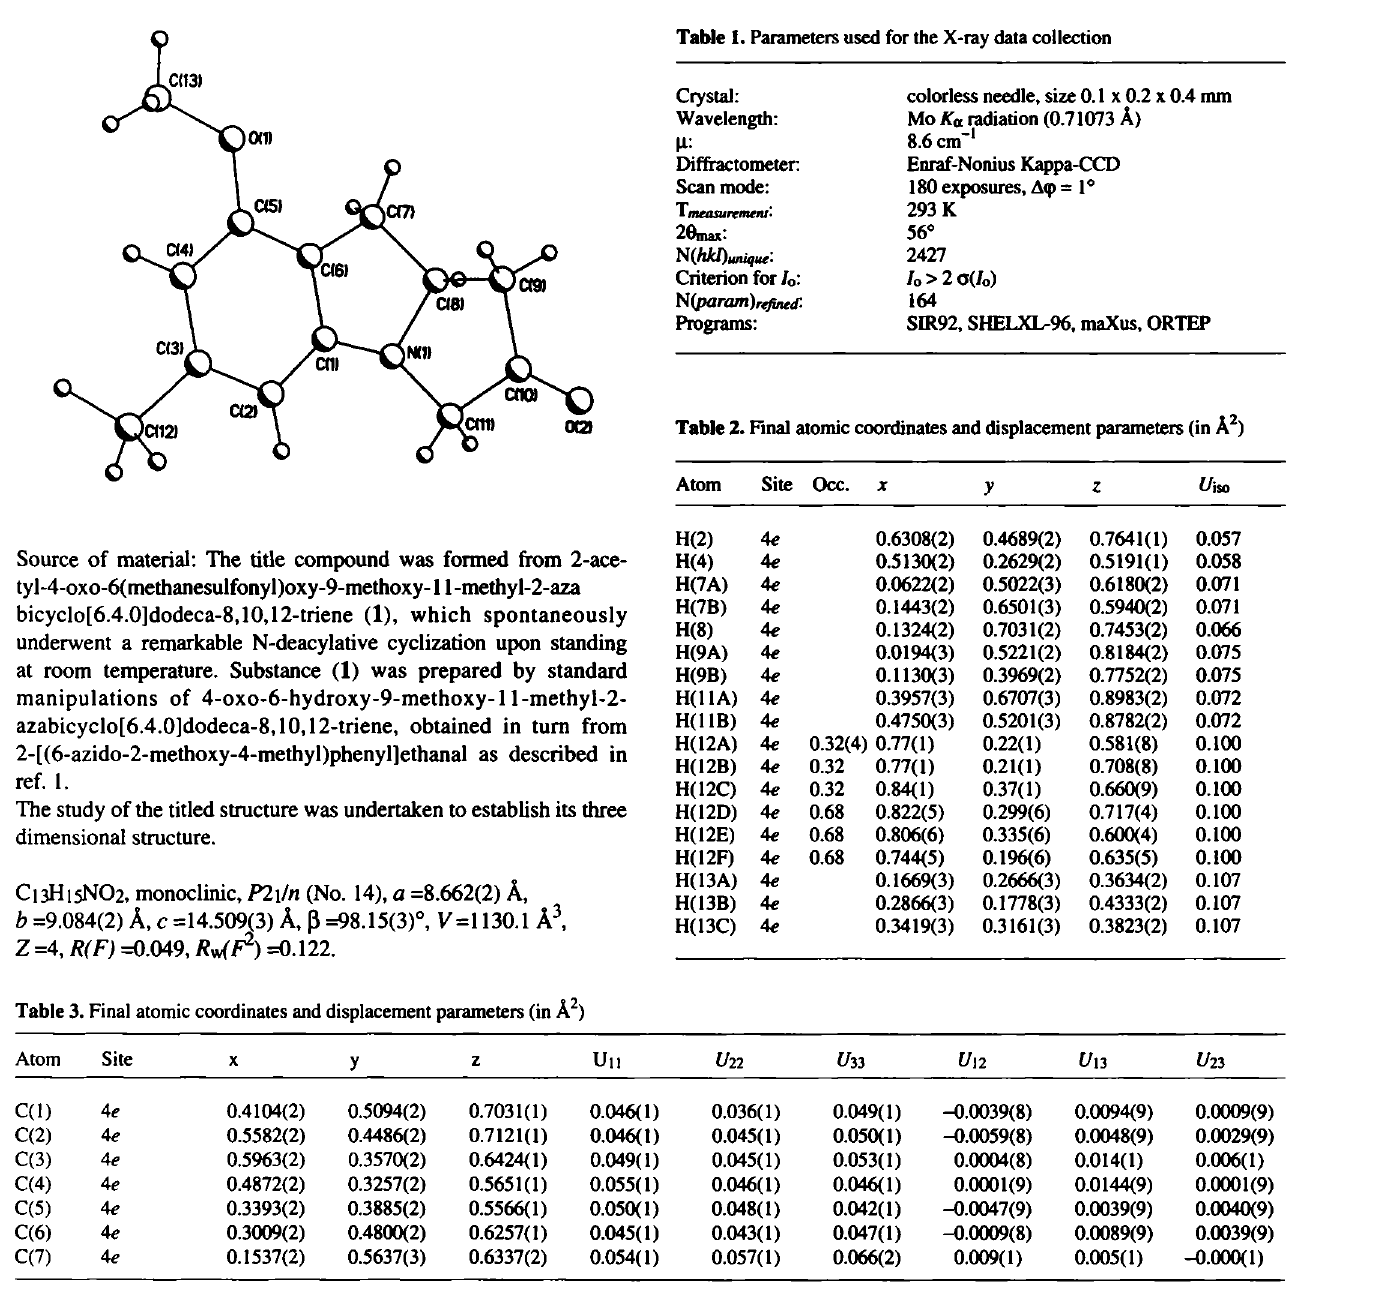
Table I. Païameters used for the X ray data collection